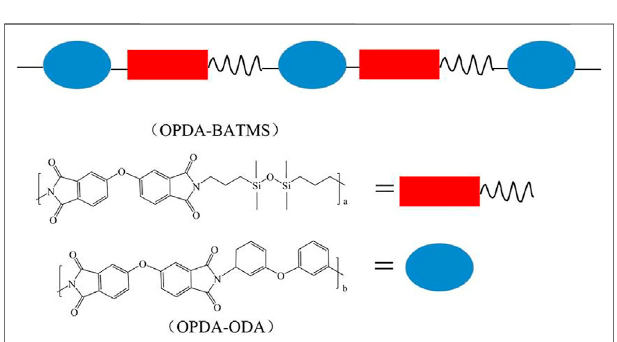
FIGURE 2 | Use of Disiloxane-Linked Diamine BATMS in Preparing Poly(imide siloxane) Films PI- χ .